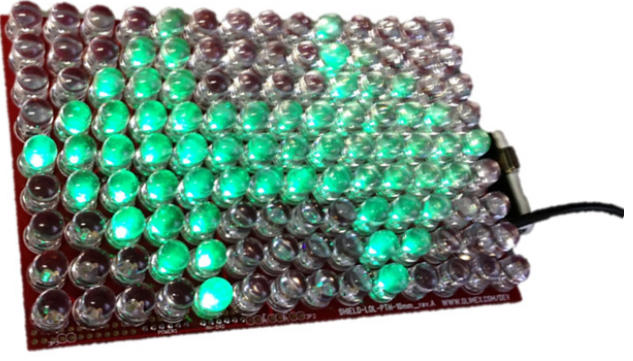
Figure 6. Double arrow shown on the LED-matrix display.